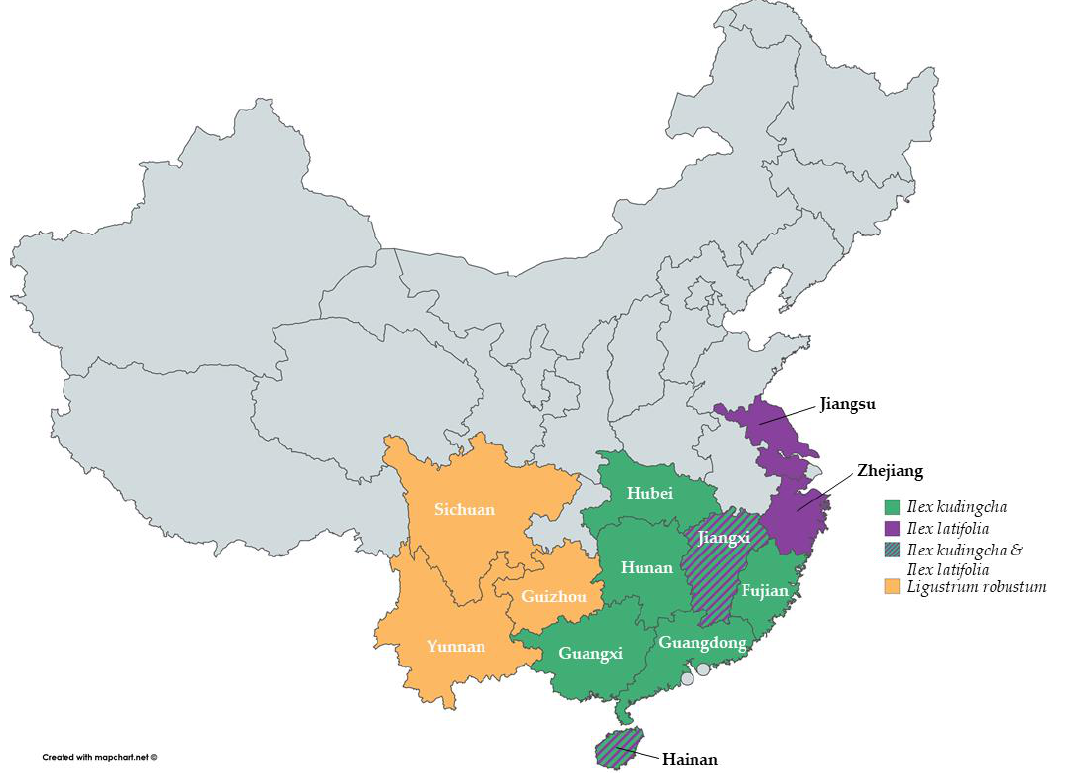
Figure 3. Reported provinces of China where the most common large-leaved Kudingcha species have been mainly found (created with mapchart.net).